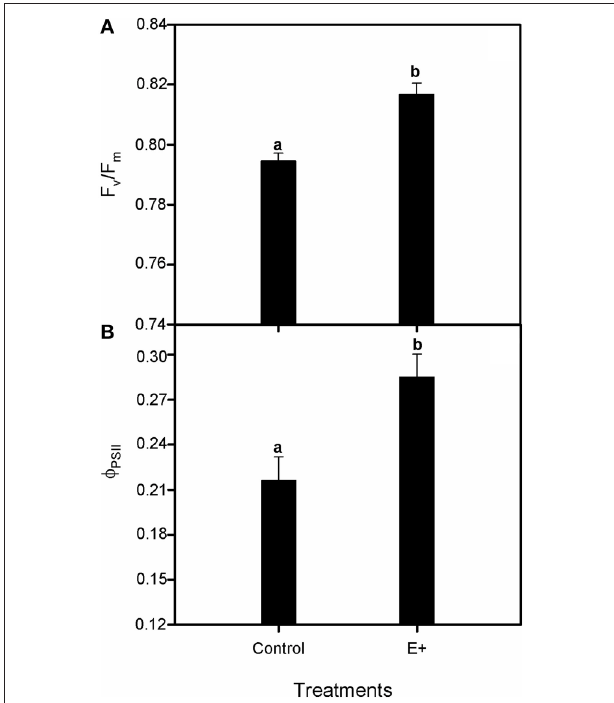
FIGURE 6 | Effect of inoculation with the endophytic bacterial consortium on maximum quantum efficiency of PSII photochemistry, F v /F m (A) and quantum efficiency, 8 PSII (B) in leaves of Spartina maritima plants grown in natural soil from Tinto marsh for 30 days. Values are means ± s.e. ( n = 10 ). Statistical differences between means are indicated by different letters ( P < 0.05